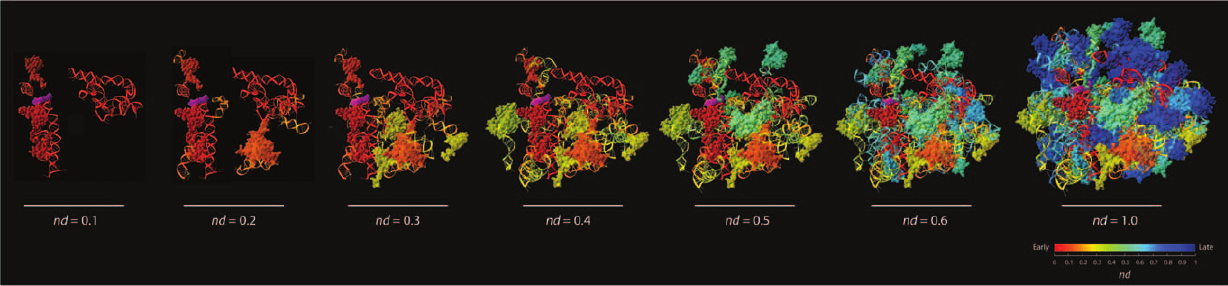
Figure 7. Model of ribosomal evolution. A chronological representation of the evolution of the ribosome shows that very early in ribosomal evolution ( nd , 0.3) rRNA helices interacted with r-proteins to form a processivity core that mediated nucleotide interactions, which later ( nd =0.3) served as center for coordinated and balanced RNP accretion leading to modern ribosomal function. The purple structure indicates extant mRNA, which is used as structural reference for location of primitive functional centers. We envision the primordial ribosome had replicative functions that likely involved RNA, so the mRNA molecule from the crystallographic model should be regarded as placeholder for the ancient coding molecule. rRNA is rendered as ribbon representation, mRNA and proteins as rendered as space-filling representations.